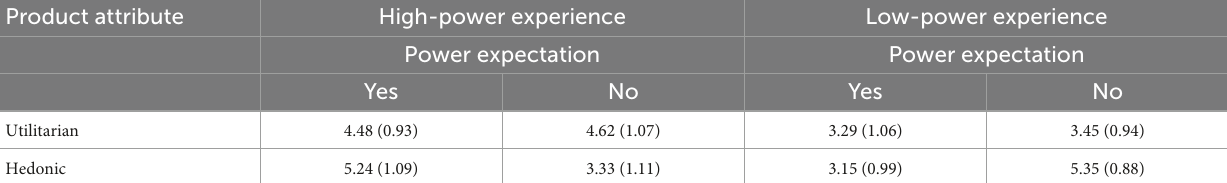
TABLE 1 Comparisons of purchase impulsiveness when the power expectation was activated or